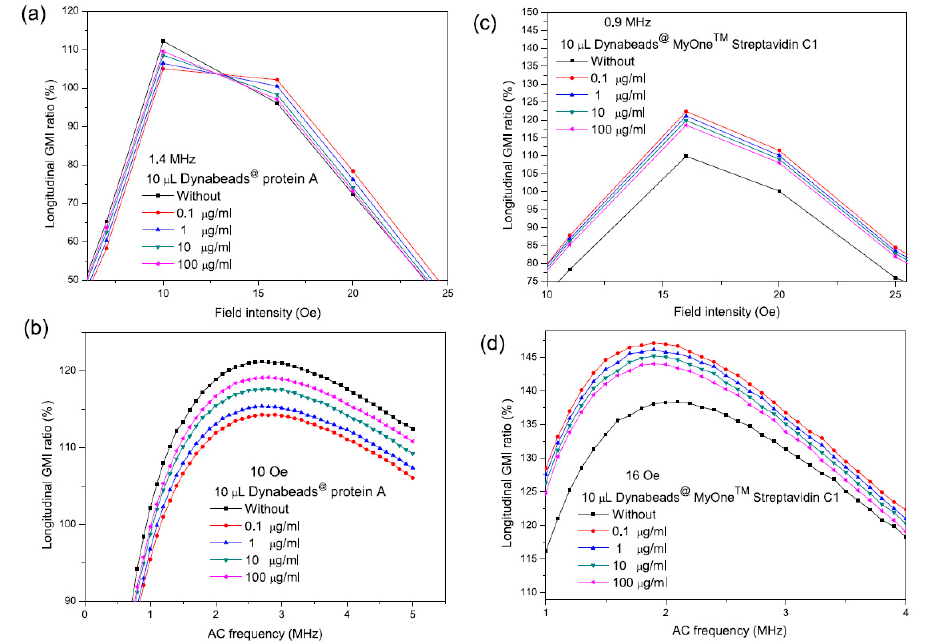
Figure 7. MI response based on magnetic particles concentration. ( a ) MI effect magnetic field dependence protein A detection based on different Dynabeads concentration. ( b ) MI effect frequency dependence for the same protein detection in ( a ). ( c ) MI effect magnetic field dependence based on different size and concentration of Dynabeads, ( d ). MI effect frequency dependence for the same Dynabeads in ( c ). Figures ( a ) and ( b ) reproduced from [112] with permission from Springer Nature, Figures ( c ) and ( d ) reproduced from [113] with permission from John Wiley and Sons.